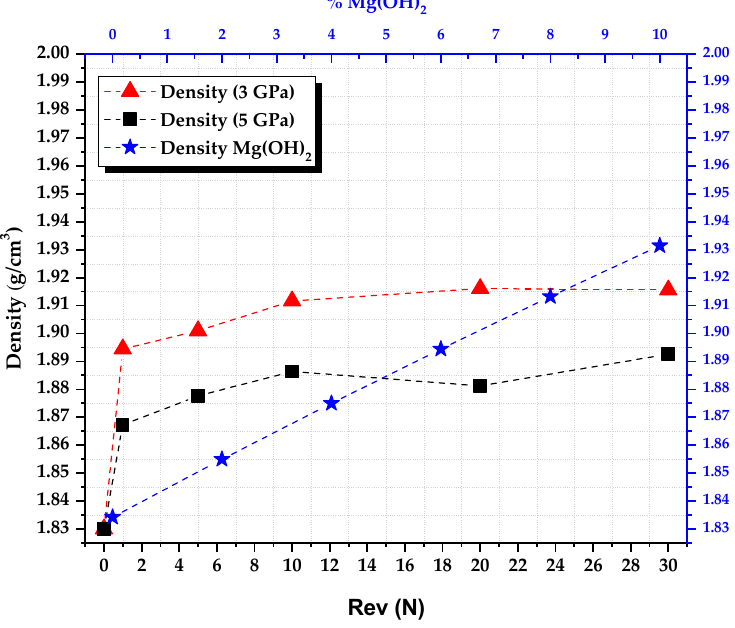
Figure 8. Measured densities of disks processed by HPT as a function of the number of revolutions N under pressures of 3 and 5 GPa (triangles and squares, respectively). The densities calculated for mixtures containing different amounts of Mg(OH) 2 are indicated by blue diamonds.